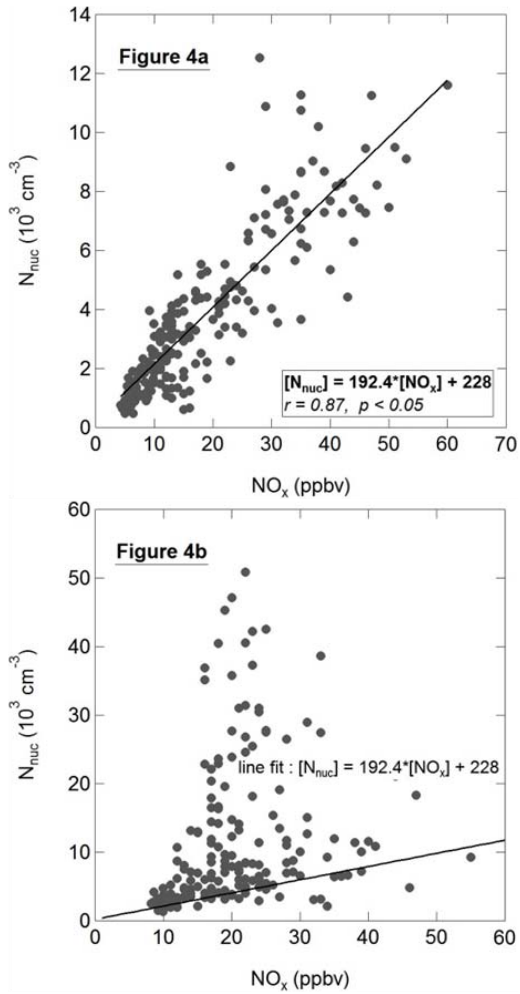
Fig. 4. Scatterplots of number concentrations of nucleation mode particle ( N nuc ) against mixing ratio of NO x during (a) nighttime (20:00–03:59LT) and (b) daytime (08:00–15:59LT). The regres- sion line obtained for nighttime data (a) was superposed onto the daytime data (b) to indicate the relationship between N nuc and NO x without disturbance from photochemical